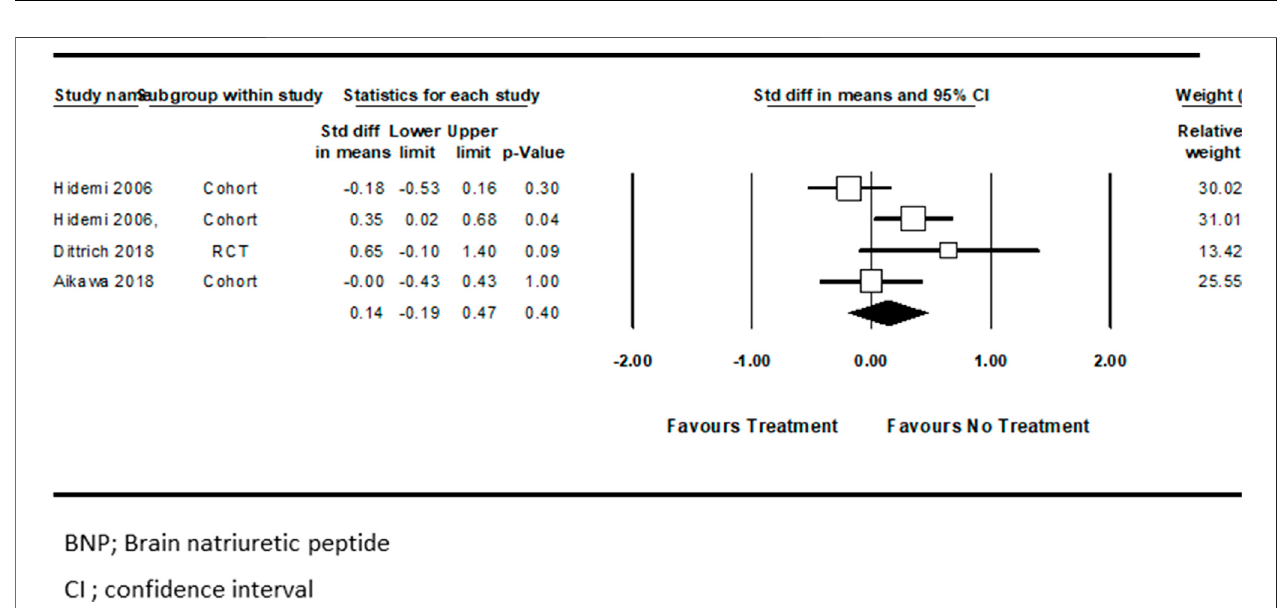
FIGURE 3 | The standard differences in means for BNP (pg/ml) following HF treatment versus control.